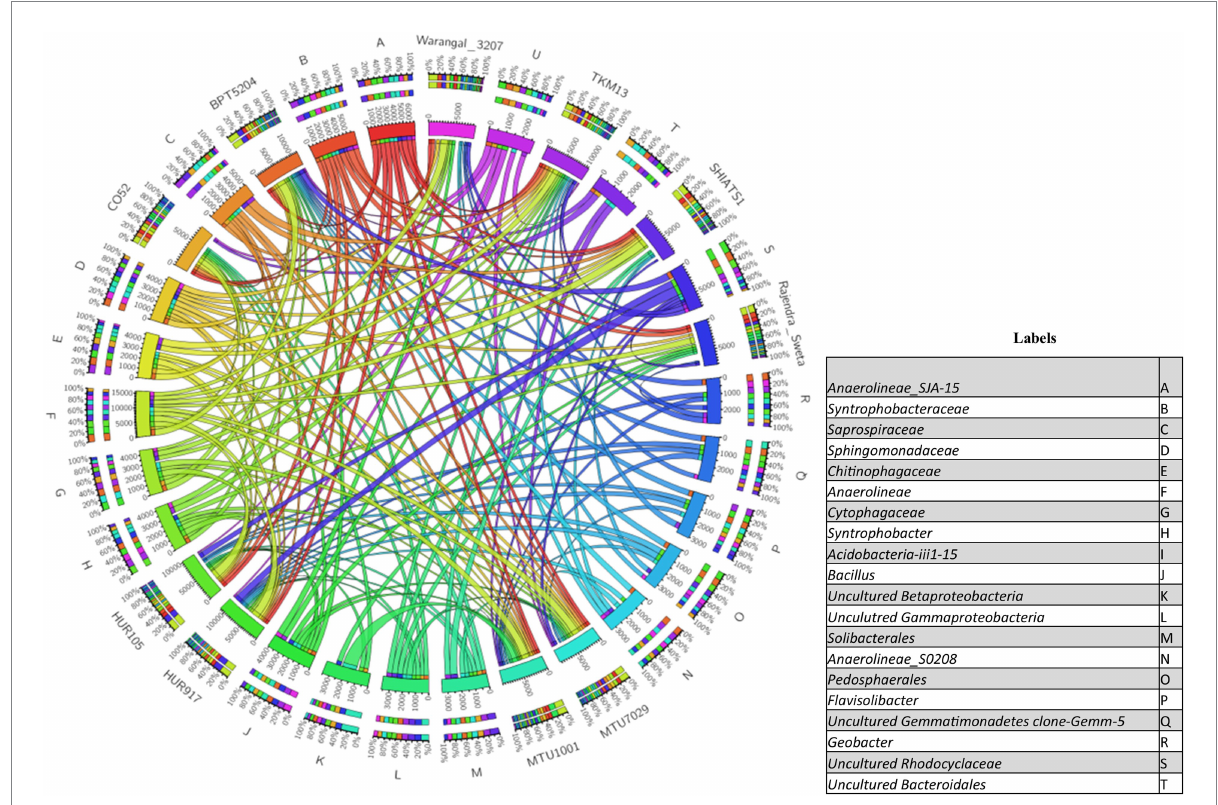
FIGURE 5 Circos plot showing the distribution of top 20 bacterial taxa (relative abundance >0.2%) associated with rhizo-microbiome of rice